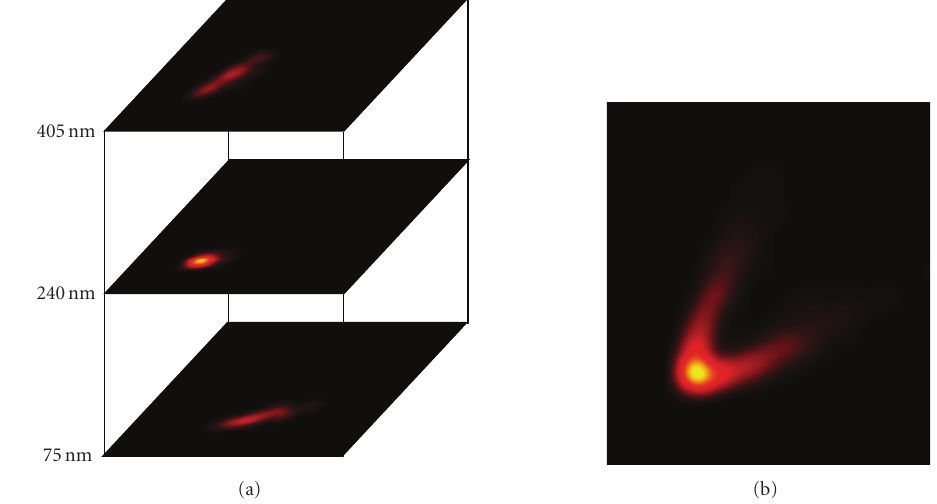
Figure 2: Calibration probability distributions. (a) 2D plots of p ( σ x , σ y | z ) at three di ff erent axial positions. (b) Total probability function p ( σ x , σ y ) of measuring a pair of widths ( σ x , σ y ). The lateral size of each image is 5